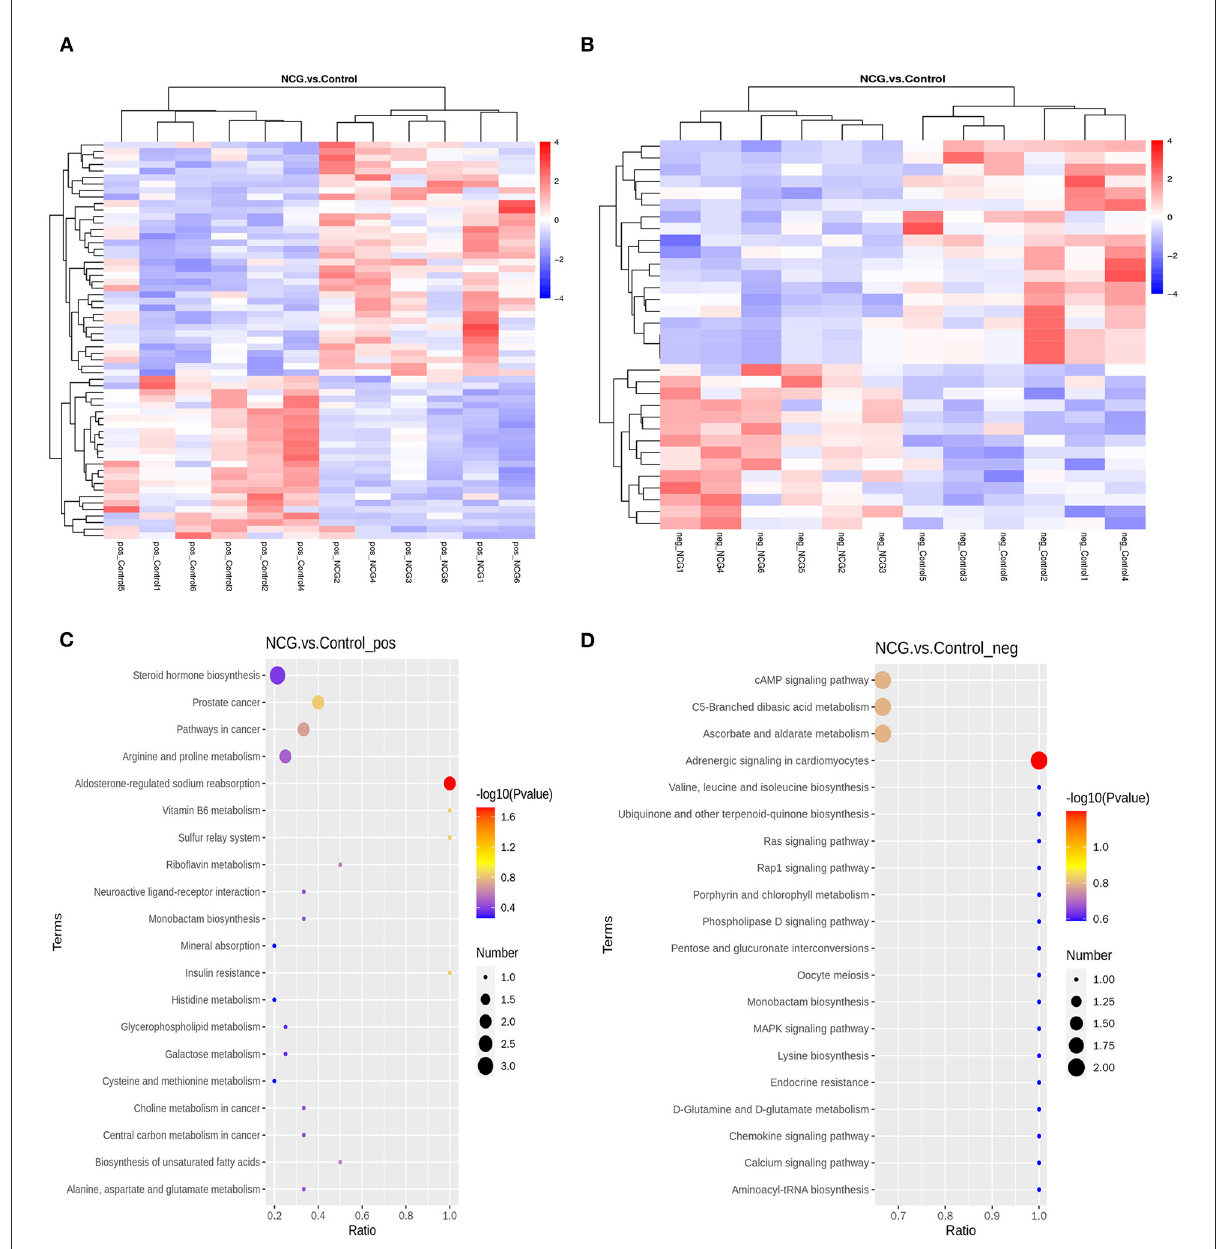
FIGURE5 Cluster heatmap for differential metabolites (DMs) under the positive (A) and negative ion modes (B) for the two treatment groups. Diagrams indicating the KEGG pathway enrichment degree for the DMs in the positive (C) and negative ion modes (D) .